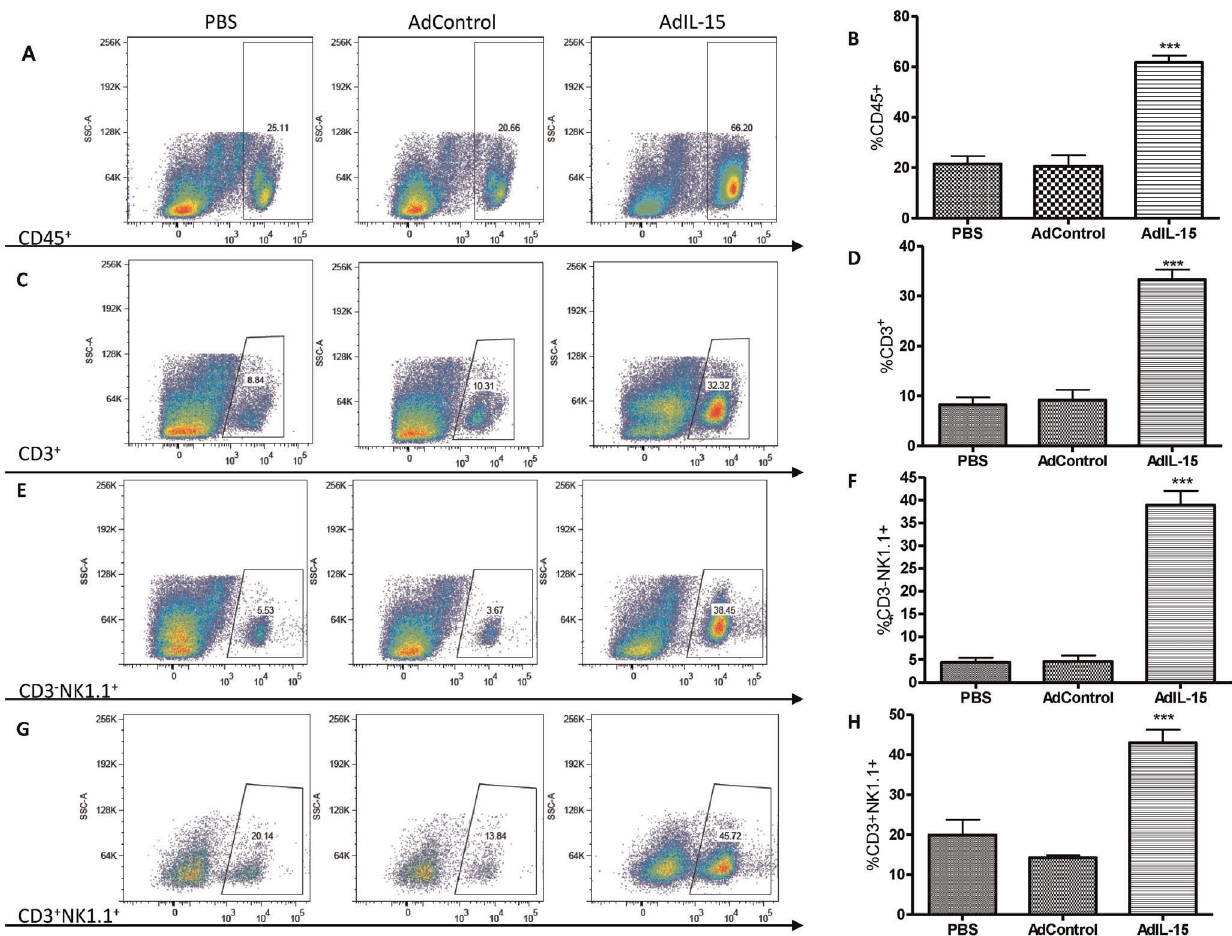
Figure 2. Acute interleukin-15 treatment results in CD45 + , NK, NKT, and CD3 + T cell accumulation in visceral adipose tissue in B6 mice. Analysis of ( A ) CD45 + , ( C ) CD3 + (T), ( E ) CD3 2 NK1.1 + (NK), and ( G ) CD3 + NK1.1 + (NKT) cell populations in visceral gonadal adipose tissue from PBS, AdControl, and AdIL-15 treated animals. The percentage of ( B ) CD45 + , ( D ) CD3 + (T), ( F ) CD3 2 NK1.1 + (NK), and ( H ) CD3 + NK1.1 + (NKT) cell populations are represented as a bar graphs (n=5 per group). ***P , 0.001.